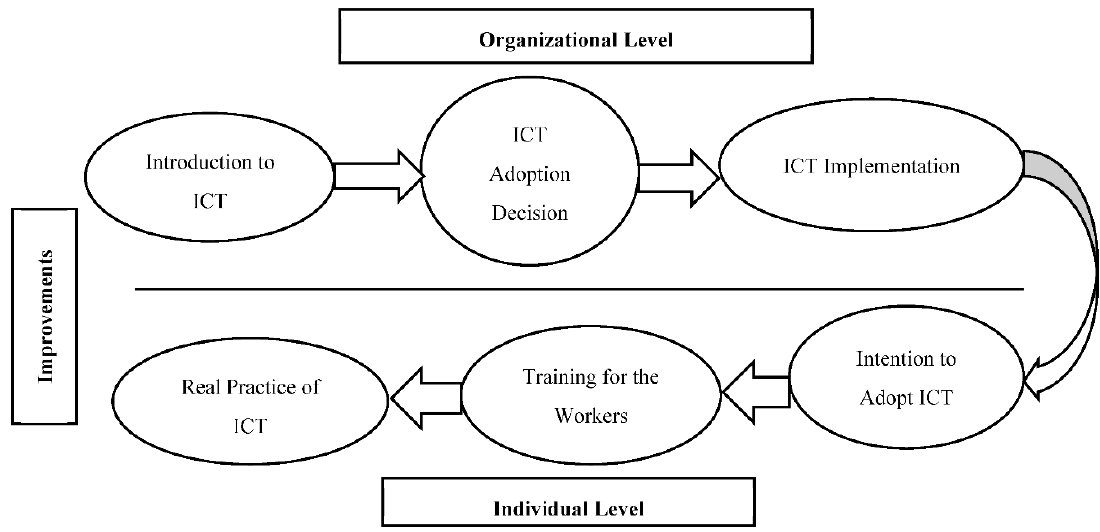
Figure 3. Multilevel of ICT adoption in the construction industry.